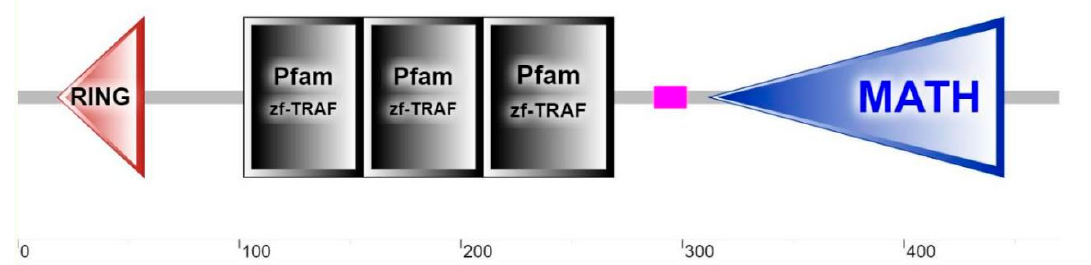
Figure 1. Putative conserved domains of EcTRAF4. One RING domain, three zinc finger domains, and one MATH domain were predicted by SMART (http://smart.embl-heidelberg.de/, accessed on 1 May 2021). EcTRAF4 shared 99.79% identity with TRAF4 of the giant grouper E. lanceolatus . A joining tree of TRAF4 proteins, EcTRAF4 clustered with the giant grouper TRAF4. The